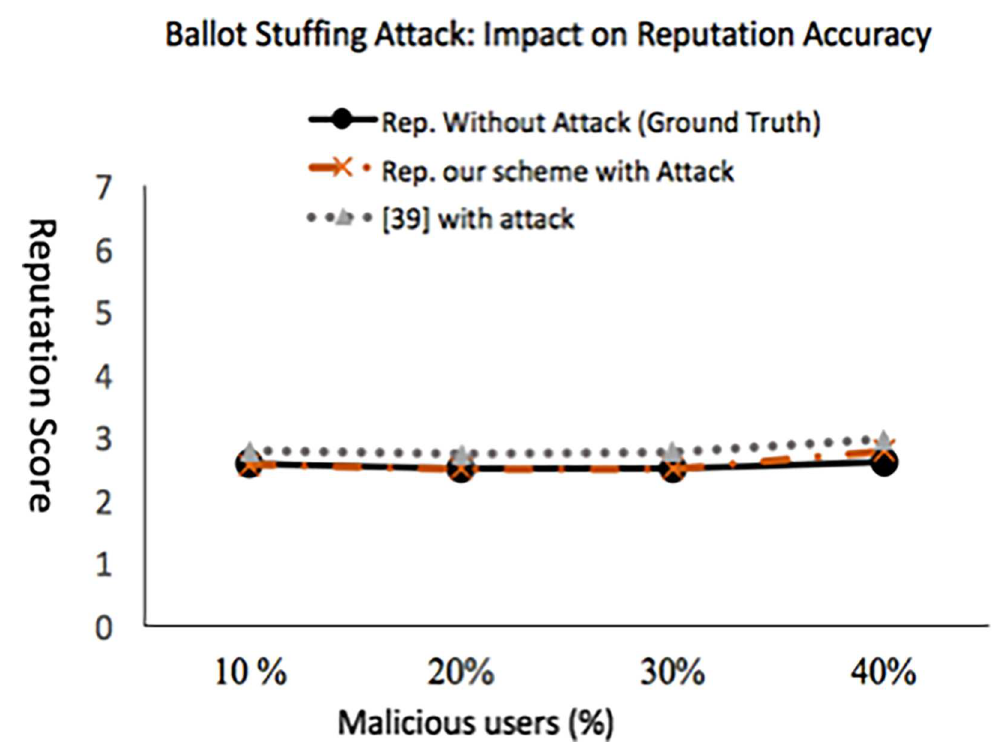
Fig 10. Impact of ballot-stuffing attack on the accuracy of reputation score when attack is done in t r .